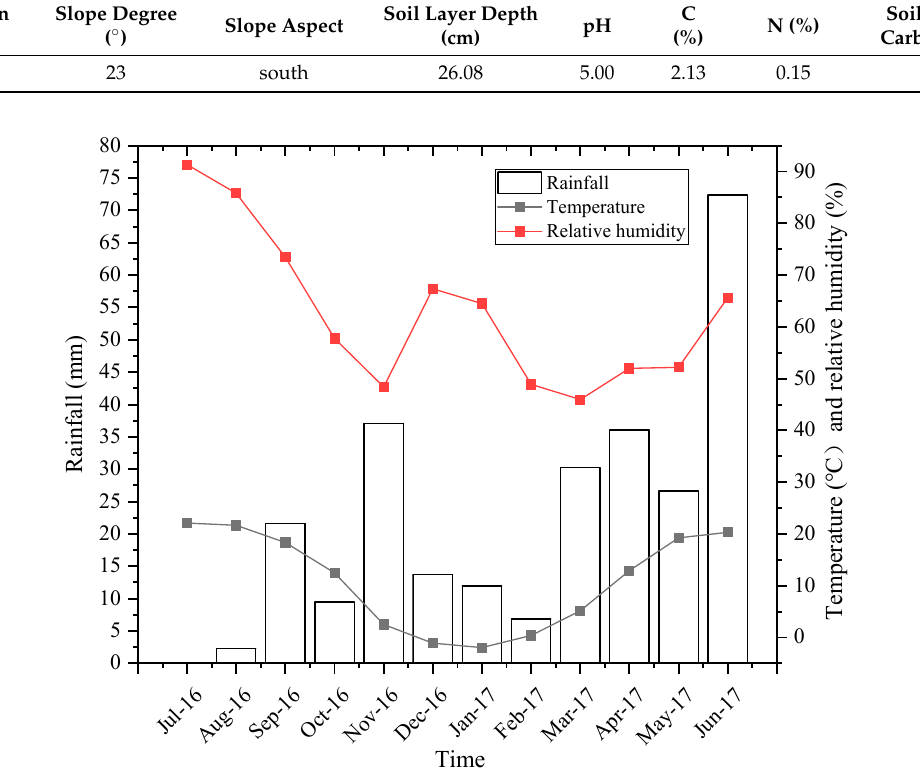
Figure 1. Monthly variation in rainfall, temperature and relative humidity during the decomposi- tion. Table 1. Specific description of the forest gap.